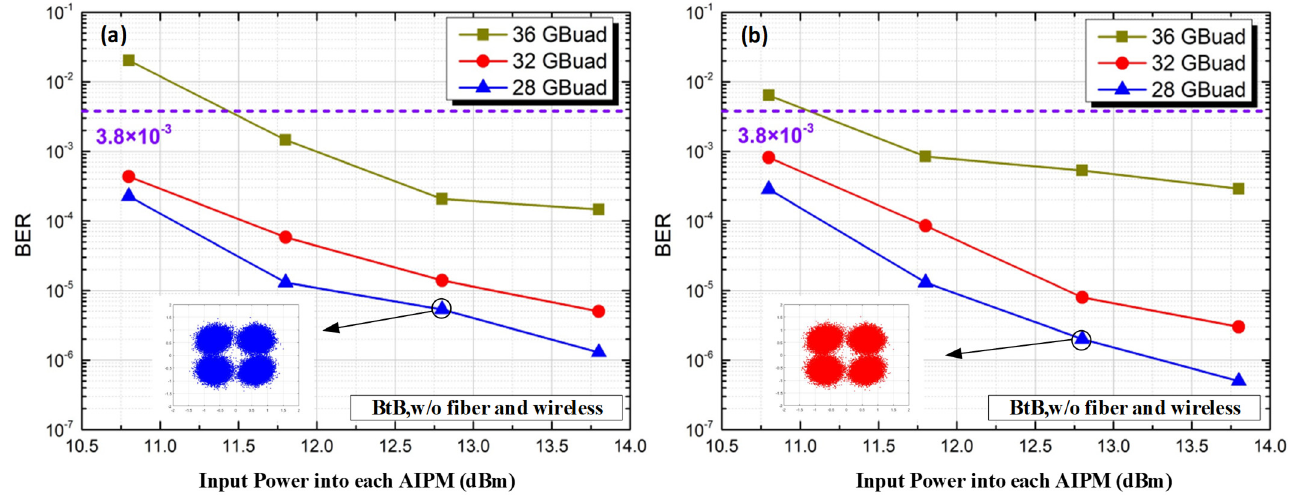
Figure 4. BER versus input power into each AIPM for the BtB case without fiber and wireless trans- mission. ( a ) X-polarization; ( b ) Y-polarization. transmission. ( a ) X-polarization; ( b )